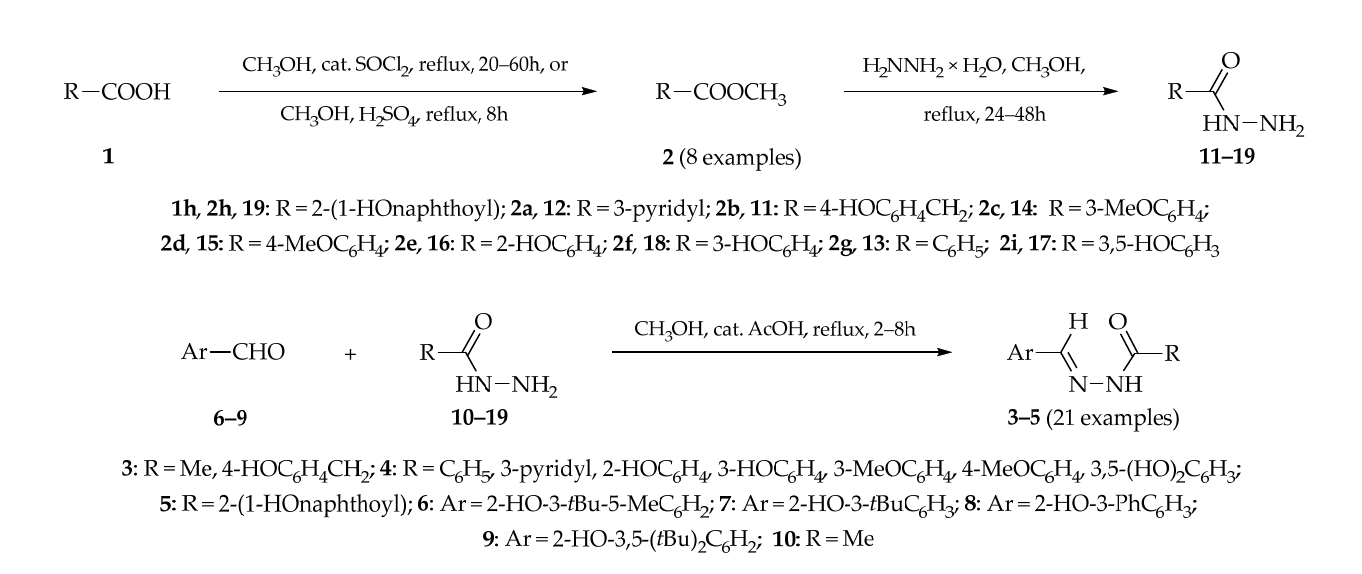
Scheme 1. Preparation of hydrazide-hydrazones 3a – b , 4a – o , and 5a – d scheme started from carboxylic acids 1 via carboxylic acid methyl esters 2 and carboxylic acid hydrazides 11 – 19 . Table 1. Characteristics of the hydrazide ‐ hydrazones 3a – b , 4a – o , and 5a – d . Table 1. Characteristics of the hydrazide-hydrazones 3a – b , 4a – o , and 5a – d